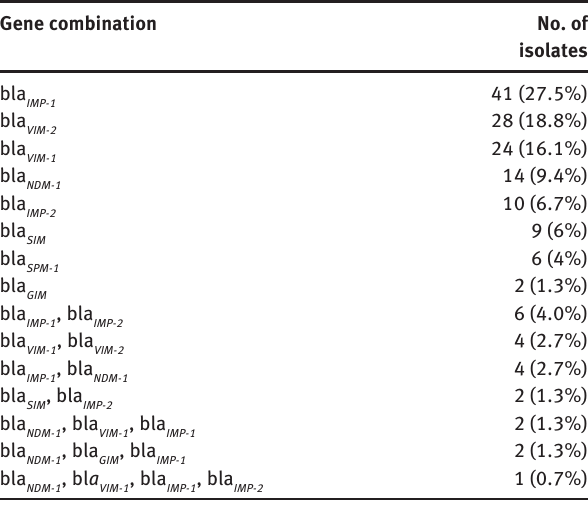
Table 5: Distribution of MBL genes among P. aeruginosa . Gene combination No.